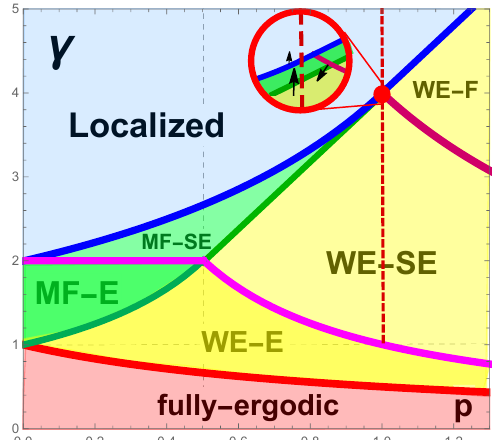
Figure 1: (Color online) Phase diagram for the log-normal RP (LN-RP) ensem- ble , F ( g ) = − ( g − γ ) 2 / ( 4 p γ ) , in the plane of effective disorder γ and the sym- metry parameter p . The phase transition lines between the Localized (L), Multi- fractal (MF), Weakly-Ergodic (WE) and Fully-Ergodic (FE) phases are shown to- gether with the lines separating the dynamical phases: Frozen-dynamics (F), Stretch- Exponential (SE) and Exponential (E). Albeit RP ensemble corresponding to RRG is not exactly log-normal, it has the same phase diagram as LN-RP with p = 1 and γ = 2 λ / ln K ≥ 1. The corresponding path in the parameter space respecting the t yp symmetry Eq. (6) is shown by a red dashed line. As the Lyapunov exponent on a → ( 1 / 2 ) ln K in the clean limit, the part of the phase diagram γ < 1 Cayley tree λ t yp is not relevant for RRG. Thus in the thermodynamic limit on RRG there is only the localized and the weakly-ergodic phase with a stretch-exponential dynamics. In the inset: finite-size phases in the vicinity of the tri-critical point. Like on RRG, a finite- size multifractality (FSMF) emerges near the localization transition. Arrows show the direction and “speed” of evolution as the system size N